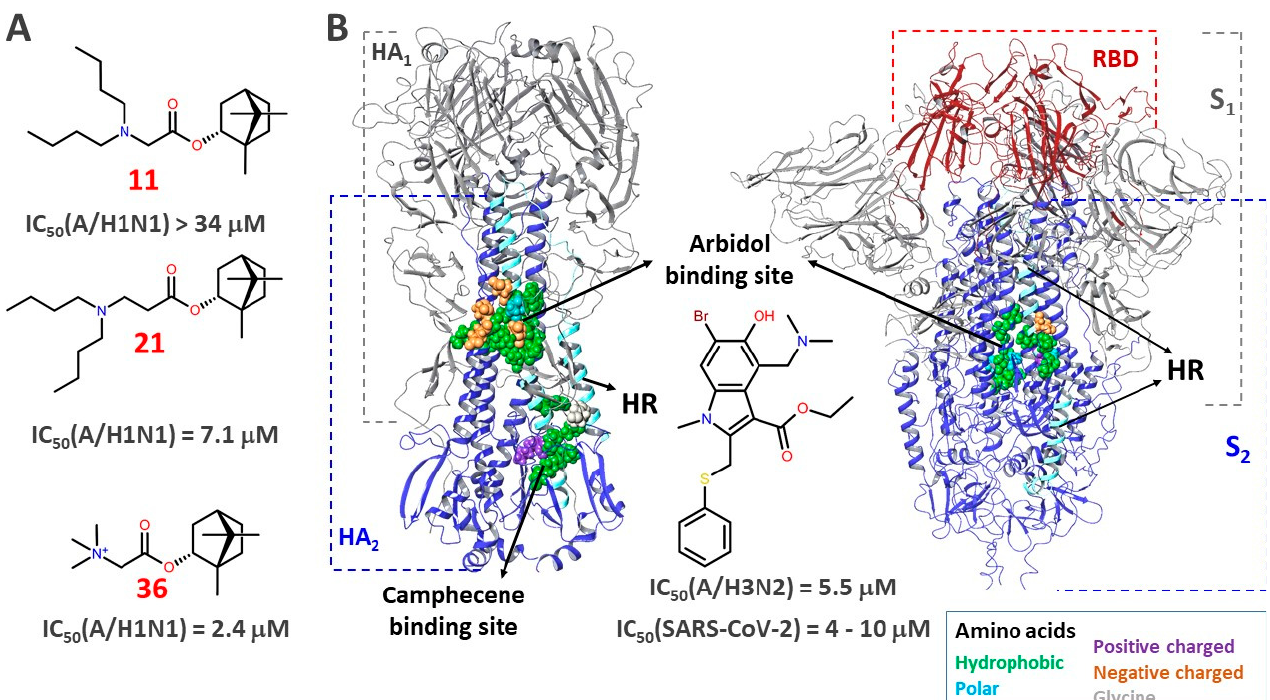
Figure 6. ( A )—Structures of compounds 11 , 21 , and 36 containing a similar structural fragment. ( B )—Surface viral proteins hemagglutinin (HA) of influenza virus and glycoprotein (S-protein) SARS-CoV-2. The secondary structures of proteins that make up the first HA1 and S1 subunits are shown in gray. The receptor binding domain (RBD) of the S-protein is shown in red. α -Heptad repeats (HR), make up the second HA2 and S2 subunits. The Arbidol binding sites in both surface proteins are located between the α -helix of the two protomers. The amino acids included in the binding site are colored according to their pharmacophoric signatures. The Camphecene binding site is located at the HA proteolysis site. Surface proteins were visualized based on the PDB [26] codes of HAs of the A/H1N1 4LXV strain [61] and the SARS-CoV-2 6VXX S-protein [62].